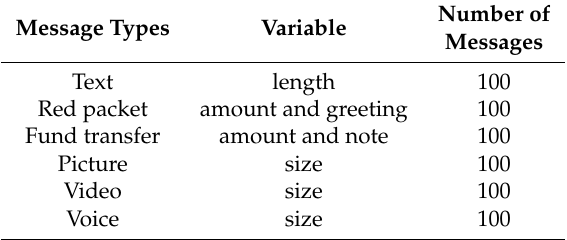
Table 2. Dataset